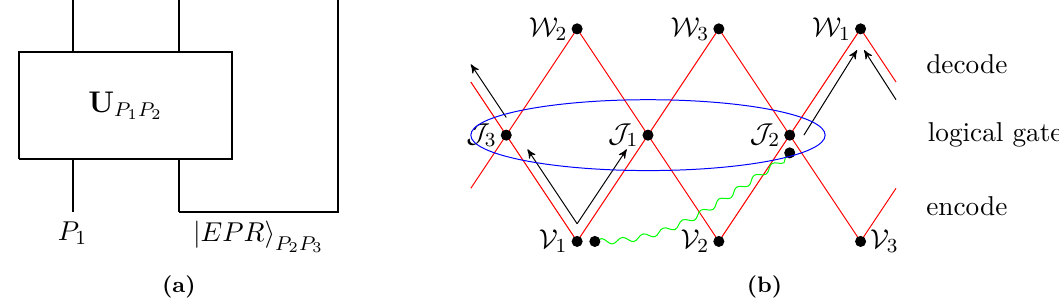
Figure 22. (a) Structure of an encoding in an EAQECC (b) Encoding of A 1 , which begins at V 1